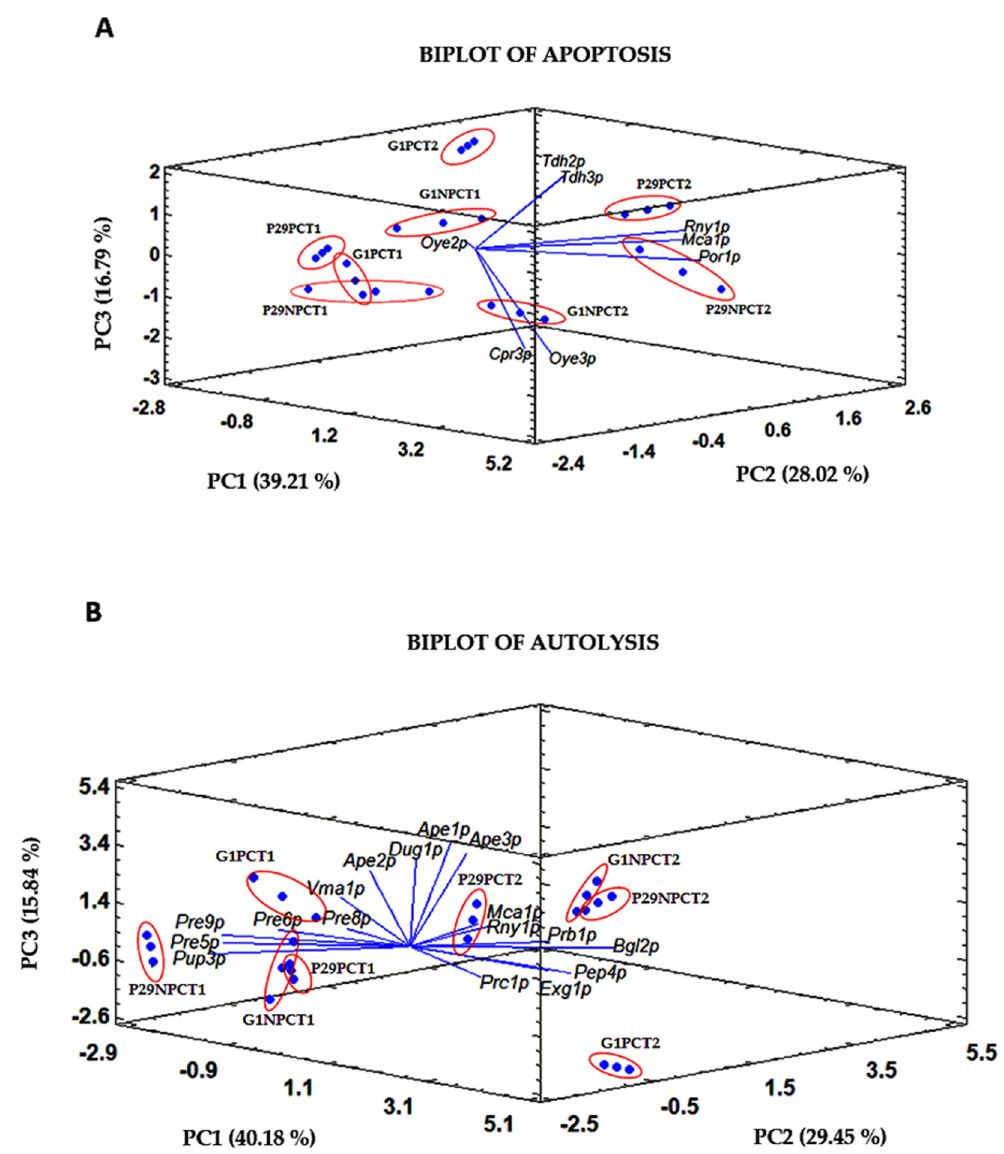
Figure 6. Biplot of Principal Component Analysis (PCA) based on the significantly different proteins identified in S. cerevisiae P29 and G1, related to apoptosis ( A ) and autolysis ( B ). Samples are shown in read circles and replicate values in blue dots.